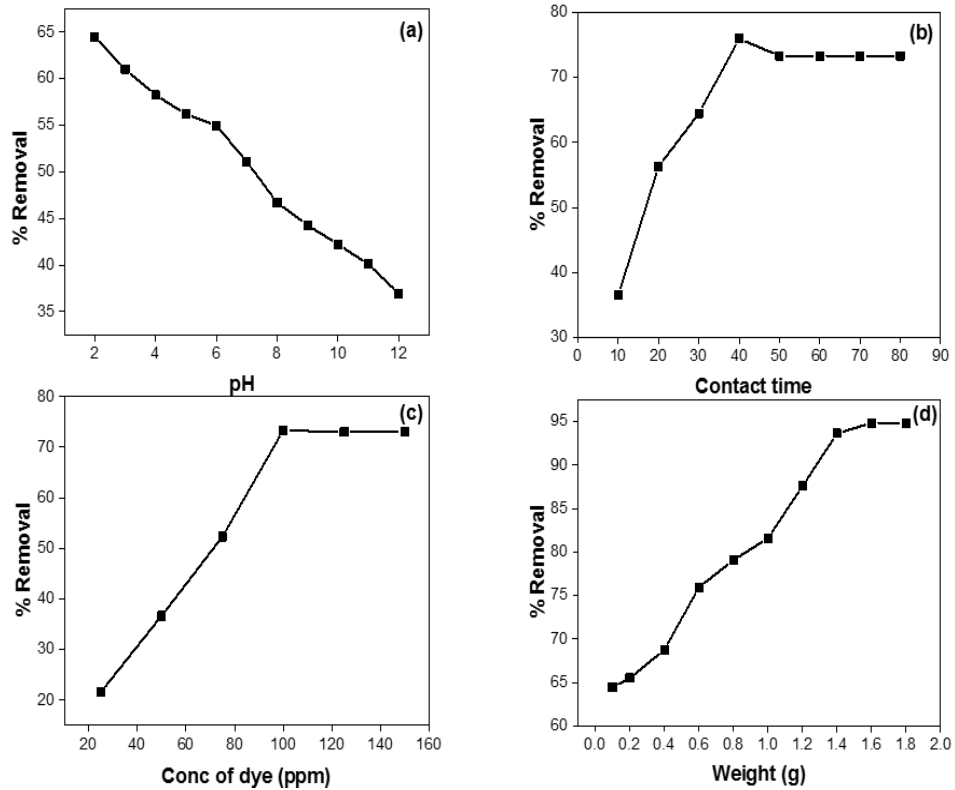
Figure 3. Effect of various parameters on the adsorption of MY using CPSMNPs: ( a ) effect of pH; ( b ) effect of contact time; ( c ) effect of initial concentration; ( d ) effect of adsorbent dose.